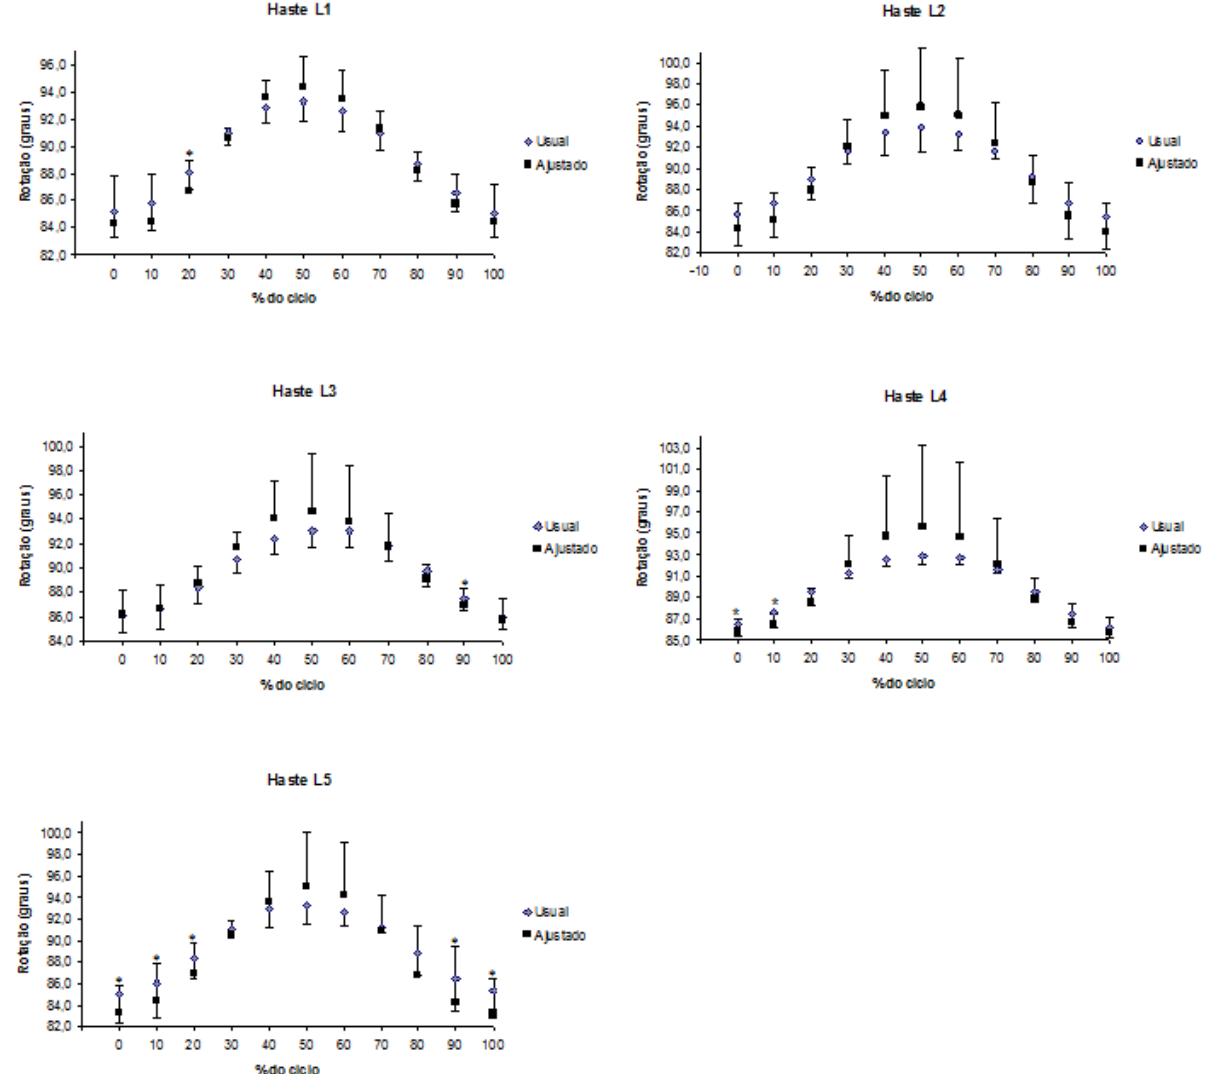
Figura 5. Comparação dos resultados de rotação da coluna lombar nas duas posições adotadas. * p<0,05 representa valor estatisticamente significativo ( Bonferroni ) entre as situações de selim ajustado e